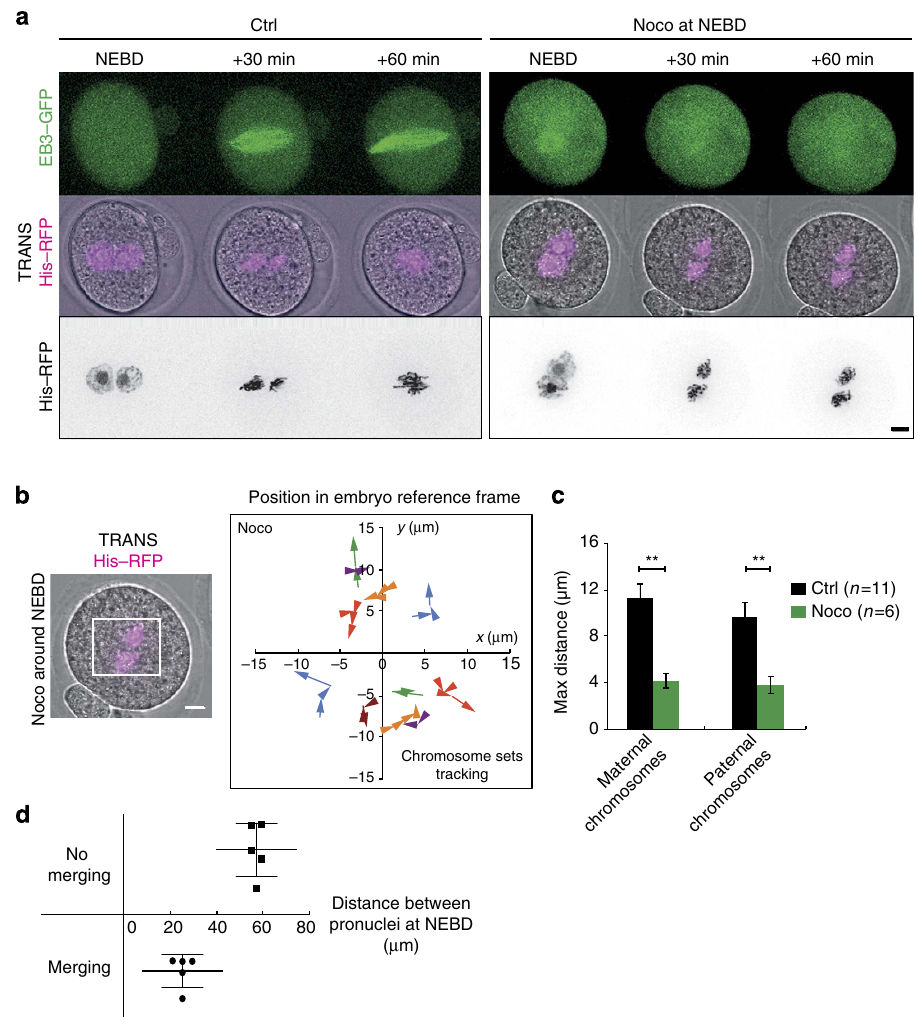
Figure 4 | Chromosome merge is dependent on microtubules. ( a ) Control embryo (left panels) or embryo treated with 1 m M Nocodazole around NEBD (right panels) expressing EB3–GFP (upper panel, green, Z-projection over 20 m m) and His–RFP (purple or black, Z-projection over 20 m m). One image is shown every 30min. Scale bar, 10 m m. ( b ) Left panel: Embryo treated with 1 m M Nocodazole around NEBD expressing His–RFP (purple, Z-projection over 20 m m) during the migration of the two sets of chromosomes. Scale bar, 10 m m. Right panel: graph showing the position of the centroid of the two sets of chromosomes in the referential of the embryo (0 being the centre) from NEBD for embryos treated with 1 m M Nocodazole around NEBD. The scale is represented by the white box on the left panel. Each colour represents an embryo. The arrows point to the last position recorded. Points are 30min apart. ( c ) Graph showing the maximum distance (that is, the distance between the points furthest apart on the trajectories) of chromosome motion in controls (black bars, from Supplementary Fig. 1c) and embryos treated with 1 m M Nocodazole around NEBD (green bars) during the migration of the two sets of chromosomes towards the embryo centre (female: left bars; male: right bars). Mean of 11 controls and 6 Nocodazole-treated embryos are shown over 2 independent experiments. s.e.m. is plotted on each bar. Statistical significance of differences is assessed with Mann–Whitney tests ( P values: female 0.0011; male 0.0011). ( d ) Dot plot showing if the two sets of chromosome merge as a function of initial chromosome distance at NEBD for 10 embryos expressing Myosin-Vb. Mean distance and s.e.m. are plotted for each